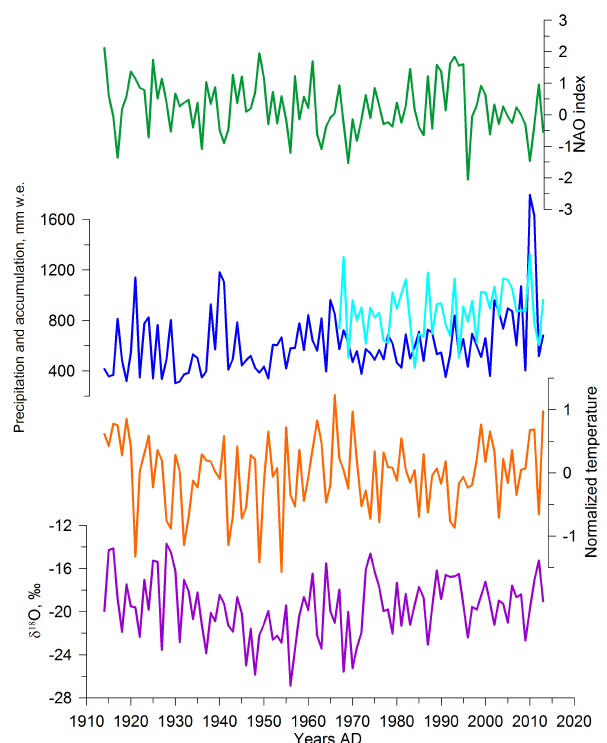
Figure 9. Comparison of the ice core record with instrumental re- gional climate information for the cold season: δ 18 O composite (purple), temperature at the drilling site calculated from the lapse rate (brown), precipitation at the Klukhorskiy Pereval station (light blue), the ice core accumulation estimate (dark blue), and NAO in- dex